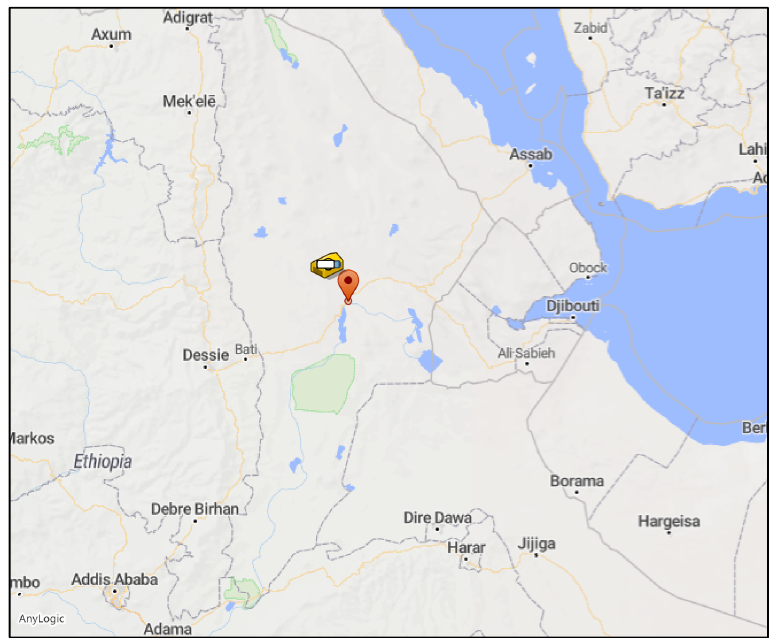
Figure 2. Map of the Afar region of Ethiopia considered in the agent-based (AB) model with the GIS location of the service center.